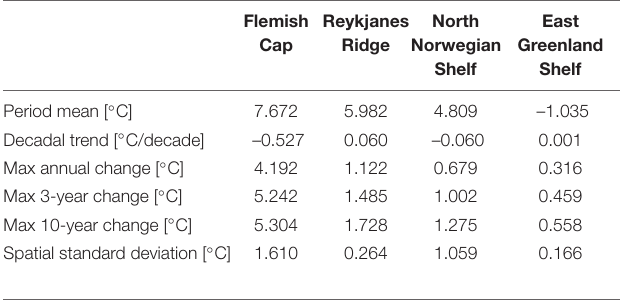
TABLE 3 | Summary of temperature properties at the four sponge habitats in waters with bottom depth 200–700 m: Period mean, decadal trend, the maximum change in the monthly mean over a period of 12, 36 months, and 10 years, and the temporal mean of the spatial standard deviation.